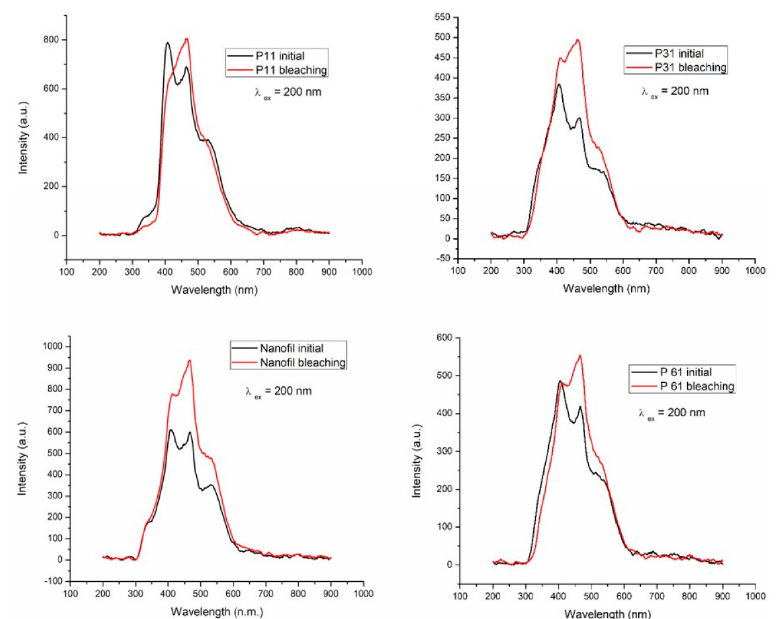
Figure 5. The emission spectrum of the four composites before and after bleaching with the G28 experimental gel.